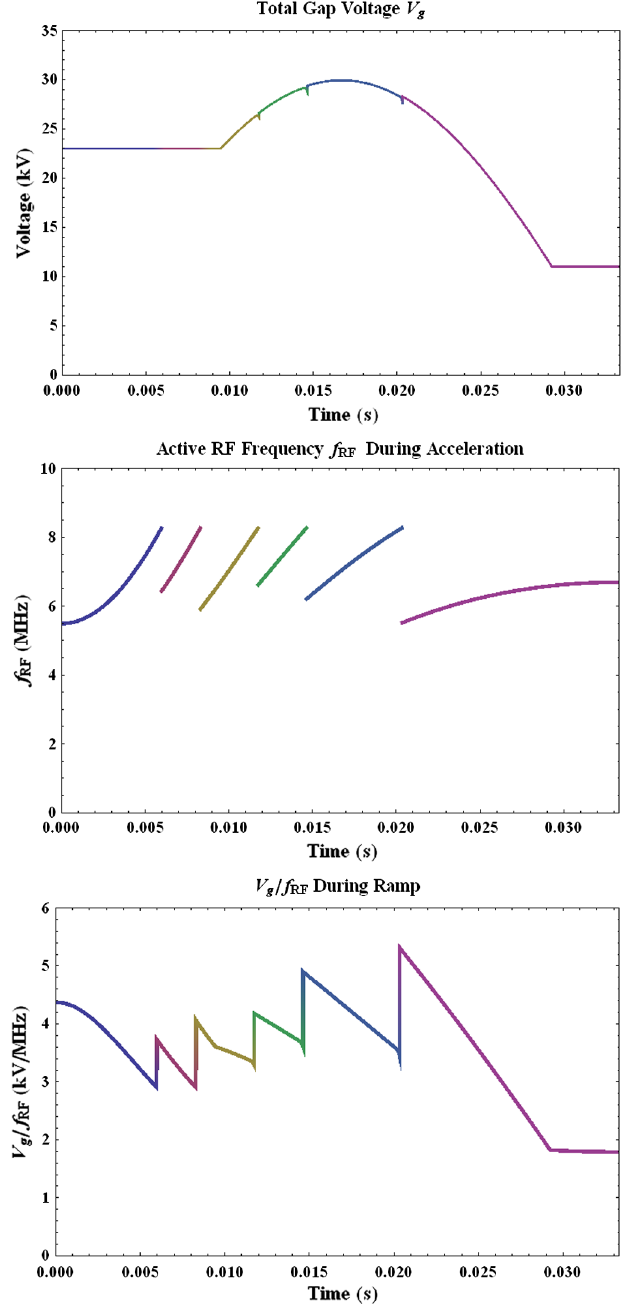
FIG. 2. Active cavity parameters for a 65 m carbon synchrotron operating at 15 Hz with ratcheting sequence of h ¼ 9 , 7, 5, 4, 3, 2. Top: active cavity voltage is shown versus ramp time. Middle: active cavity frequency. Bottom: ratio of cavity voltage to frequency is plotted; this ratio remains fairly consistent through- out the entire acceleration